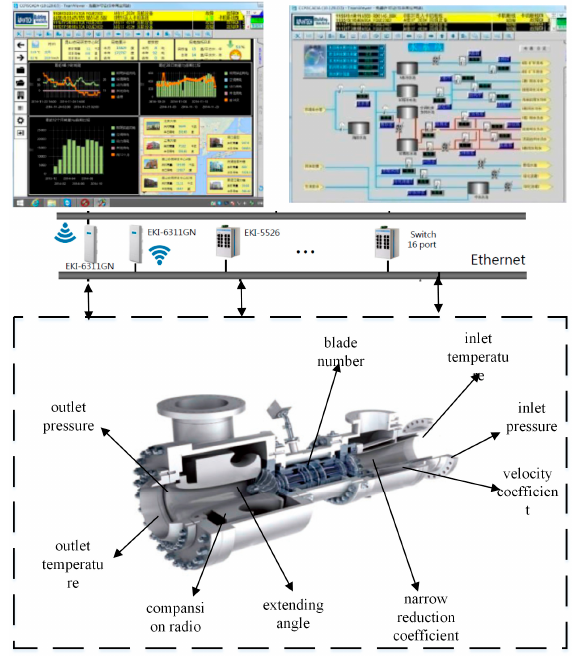
Figure 2. The illustration of the performance monitoring of turbo-expander in industrial IoT.